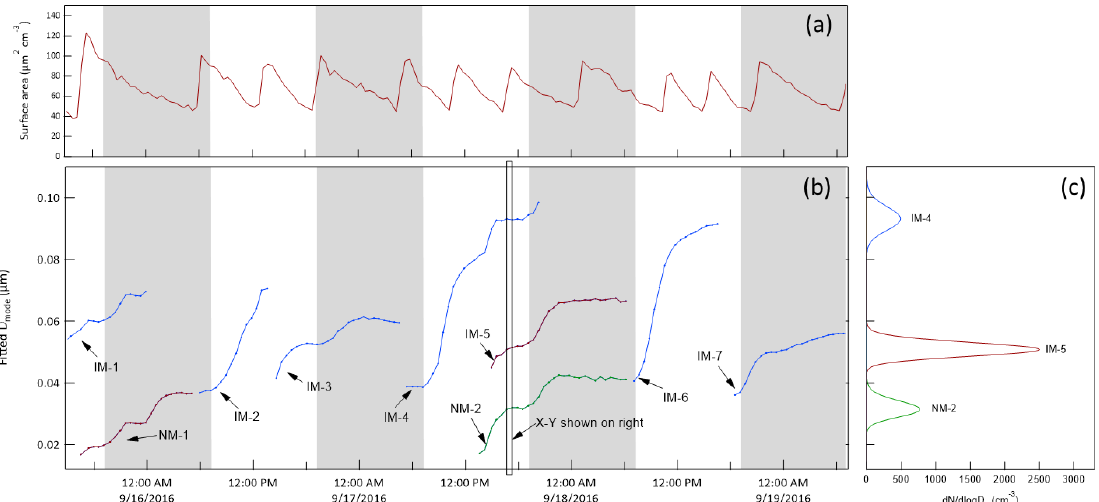
Figure 11. (b) Time series of the lognormal fit diameters of injected and nucleation modes identified in Fig. 10. Different colors are used when two or modes overlap in time. (c) Lognormal fits to the three modes tracked at the time indicated by the rectangle in the time series. (a) Integrated surface area concentration showing the result of slow decay followed by an automatic injection of ∼ 0.3µm particles each time the concentration fell below 40µm 2 cm − 3 . The shaded bands represent